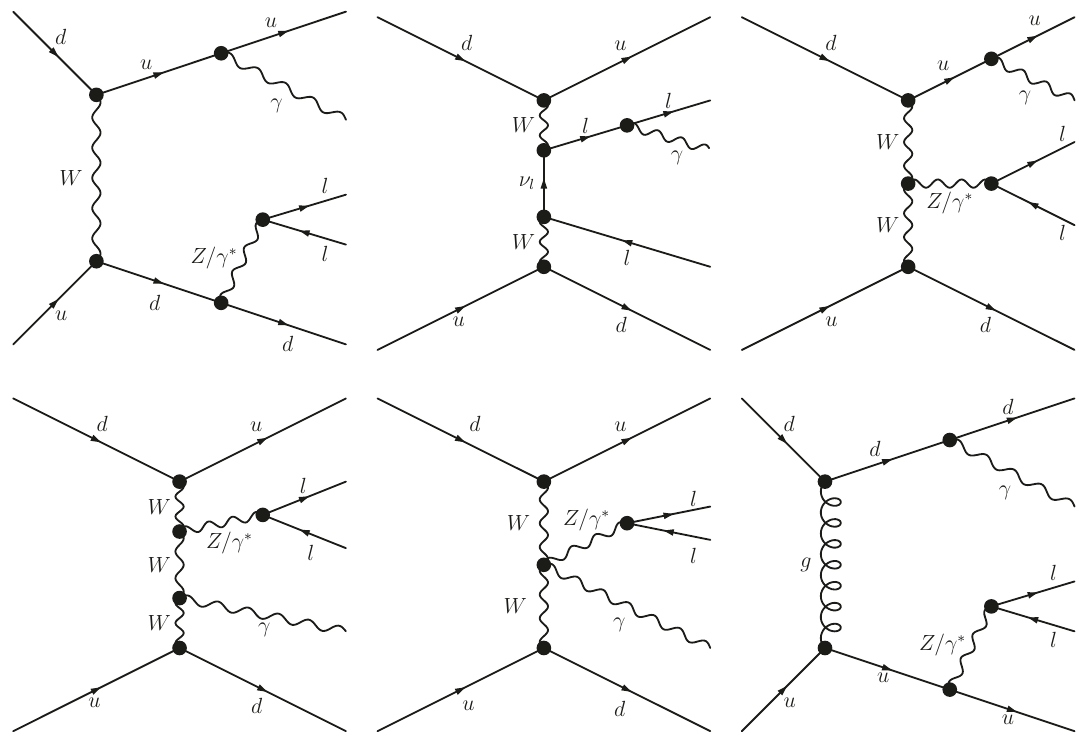
Figure 1 . Representative Feynman diagrams for Z (cid:13) jj production. The diagrams except (lower right) re(cid:13)ect EW origin: (upper left) bremsstrahlung, (upper center) multiperipheral, (upper right) VBF with TGCs, (lower left) VBS via W boson, (lower center) VBS with QGCs, while (lower right) is a QCD-induced